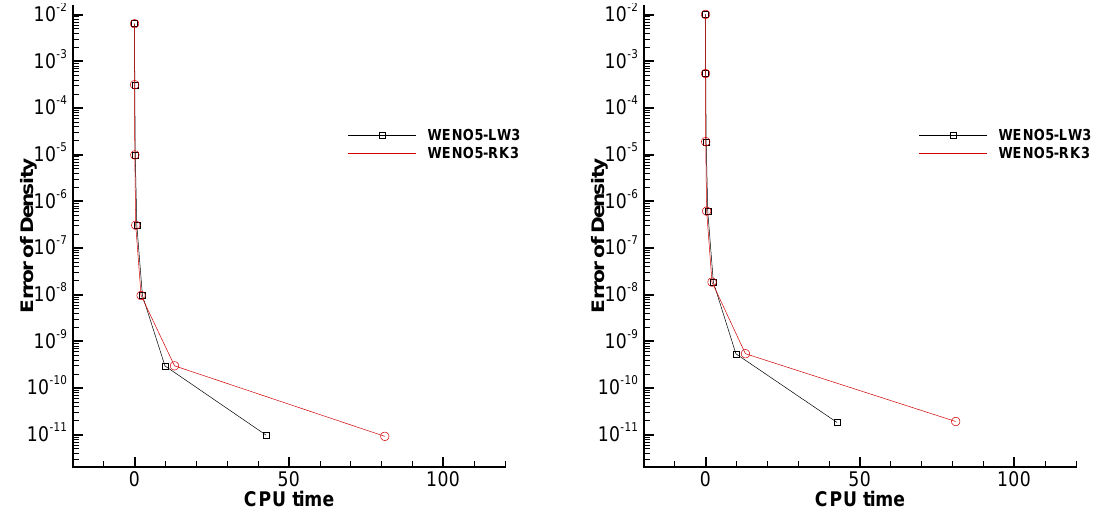
Figure 2. Numerical errors of density and CPU time for the one-dimensional order test in Example 1: ( Left ) L 1 error; and ( Right ) L ∞